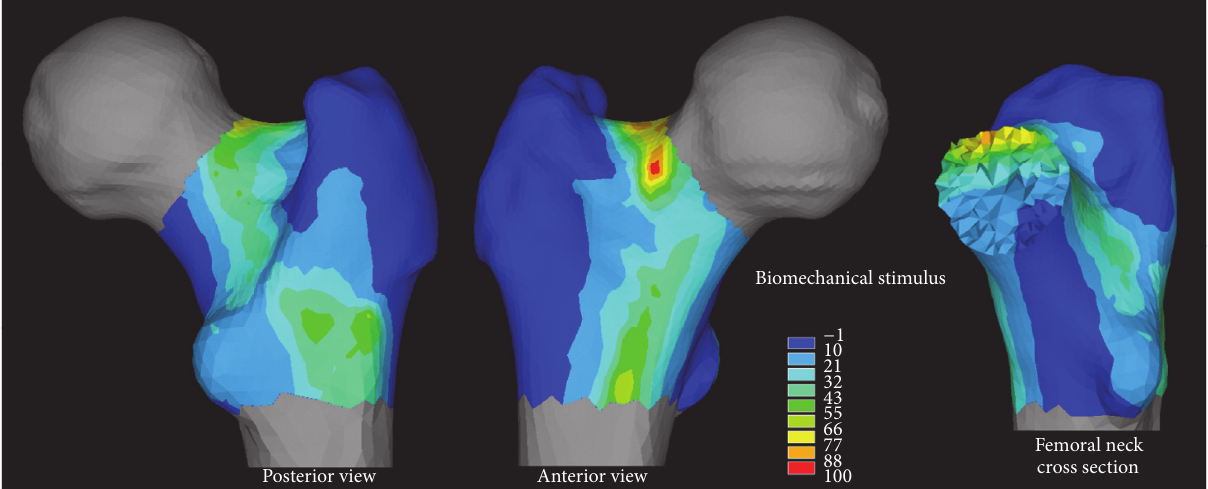
Figure 5: The biomechanical stimulus for bone adaptation. From the left hand side, a frontal view, a posterior view, and the distribution of the biomechanical stimulus over a medial cross section of the femoral neck